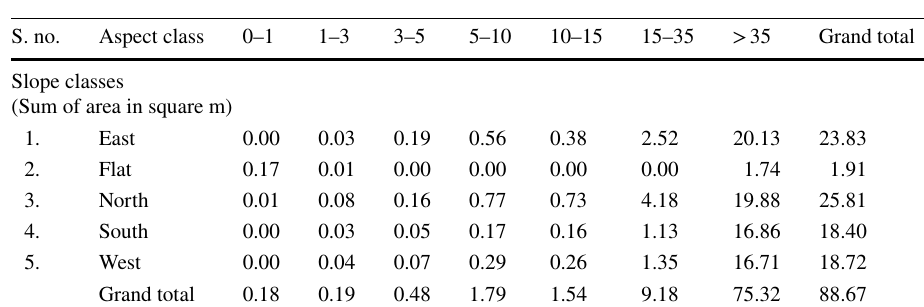
Table 5 Area and aspect of different slope